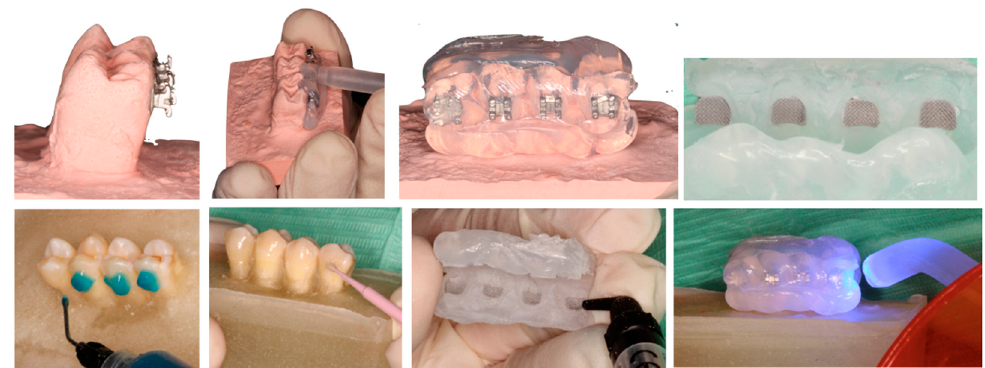
Figure 2. Representative images of indirect bonding samples steps (group 4).